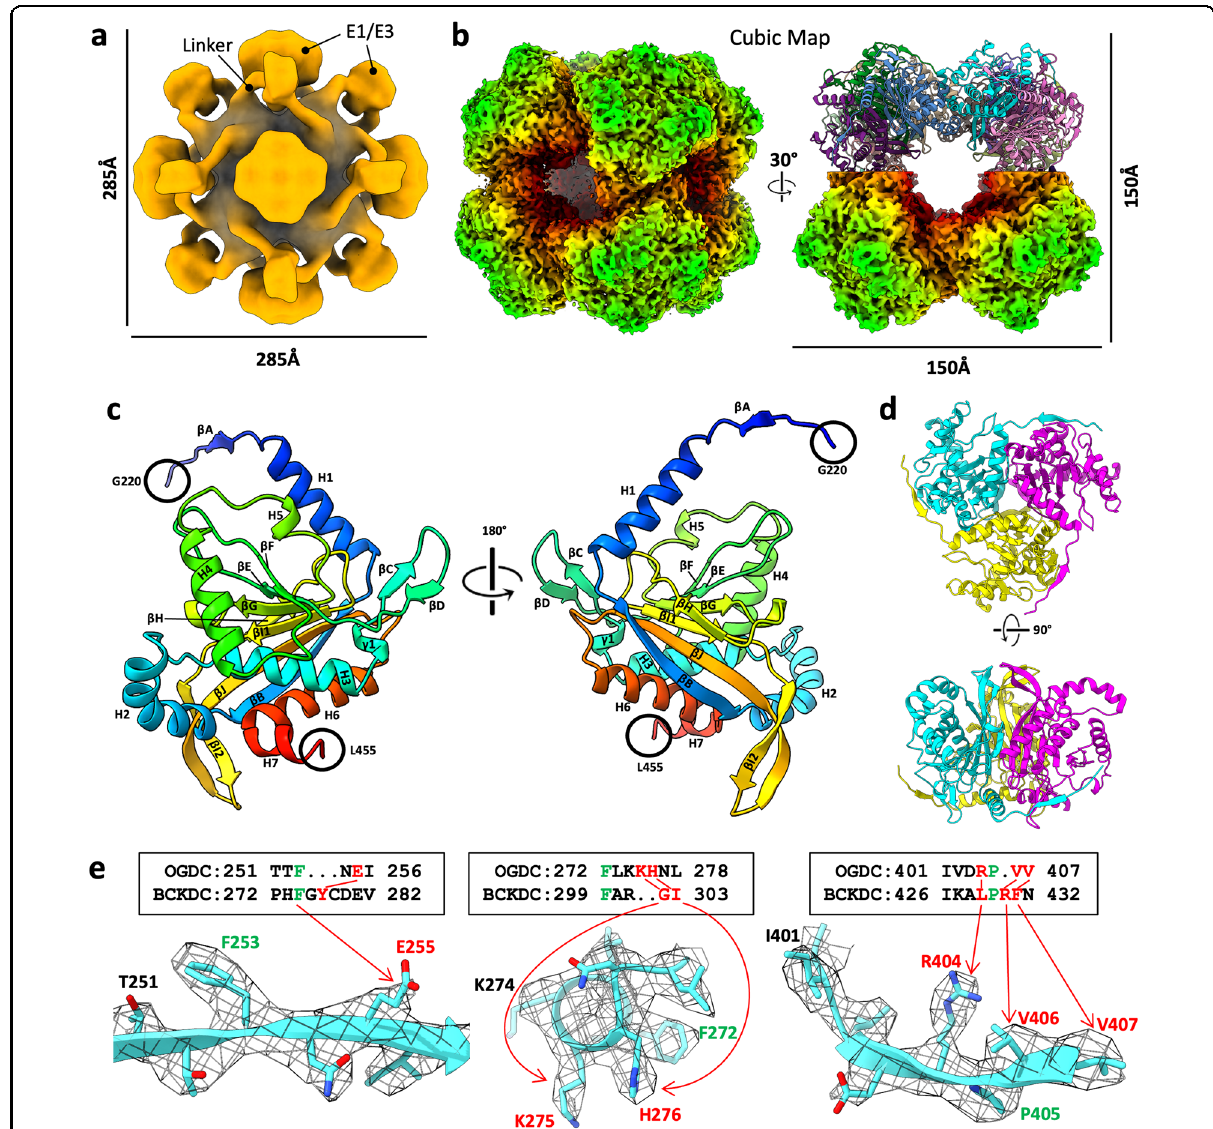
Fig. 2 Cryo-EM reconstruction and identi fi cation of bovine OGDC core. a 3D reconstruction of the full OGDC with octahedral symmetry showing external densities (orange) around the core density (gray). Linkers extend from each E2o subunit toward a density along the edges of the core. Additional large densities are present atop the faces of the core. b Two views of the cryo-EM density map of E2o core colored by radius, with half of our E2o atomic model assembly in the right. c Rainbow-colored ribbon of E2o IC domain atomic model with secondary structures labeled. Resolvable N-terminal residues (blue) and C-terminus (red) are indicated. d Structure of the E2o IC domain trimer, colored by subunits. e Sequence alignment of E2o and E2b with side-chain fi t of corresponding E2o sequence into cryo-EM density map. Green letters indicate conserved residues between E2o and E2b that establish landmark features in cryo-EM density. Red letters and arrows indicate mismatch of residue identity in E2b with corresponding cryo-EM density, thus establishing the map to be that of